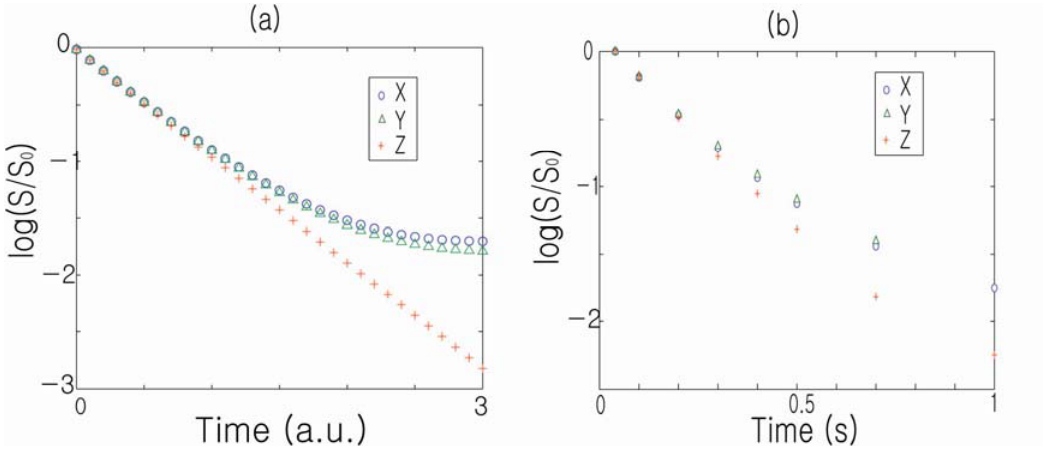
Figure 8. ( a ) Calculated decay characteristics of the unresolved DDIF signal when the external gradient is applied along the x , y and z directions, respectively; ( b ) Corresponding experimental measurements of the DDIF-signal decay. Reproduced from Reference [43] with